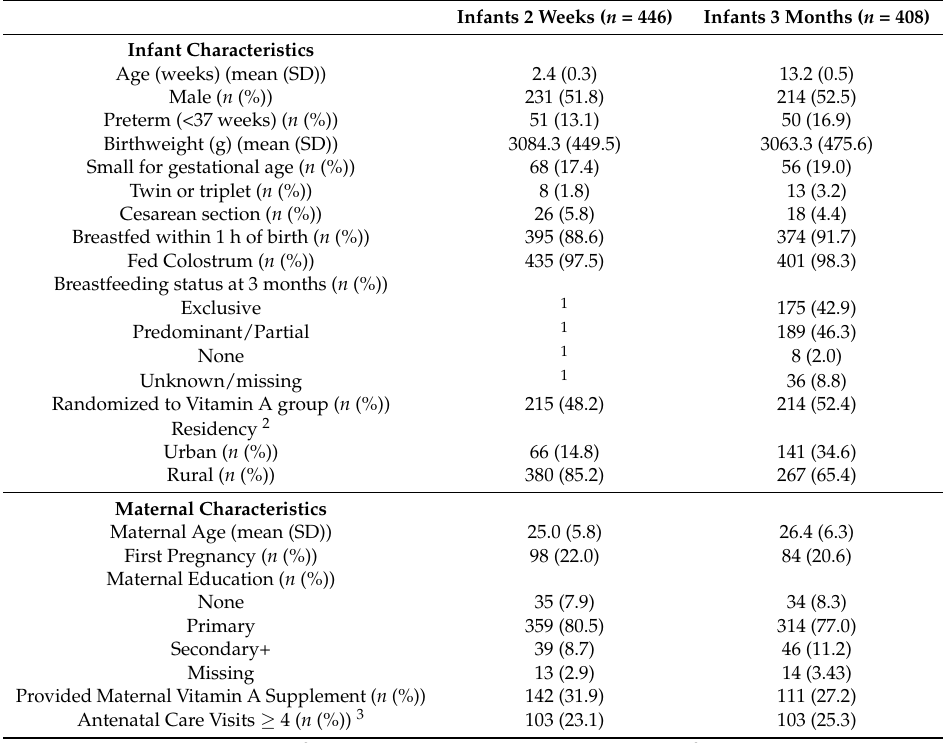
Table 2. Infant and maternal baseline characteristics for